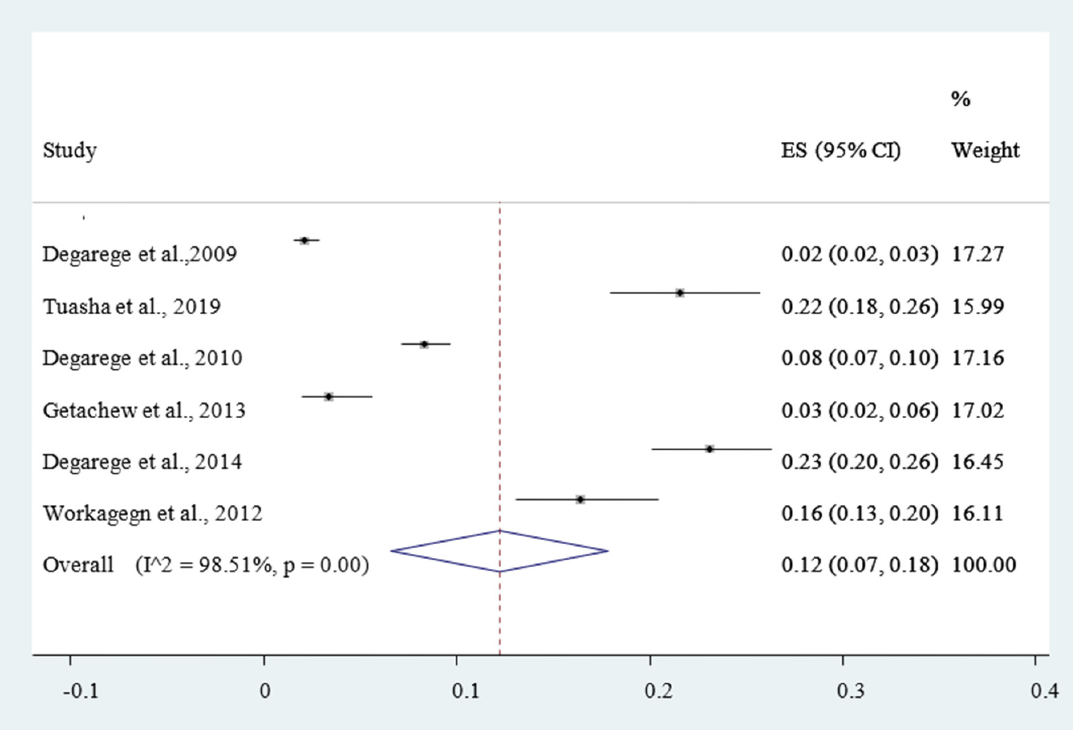
Figure 9. Forest plot of 6 studies on magnitude of Trichuris trichiura infection among outpatients in Ethiopia, 2020.